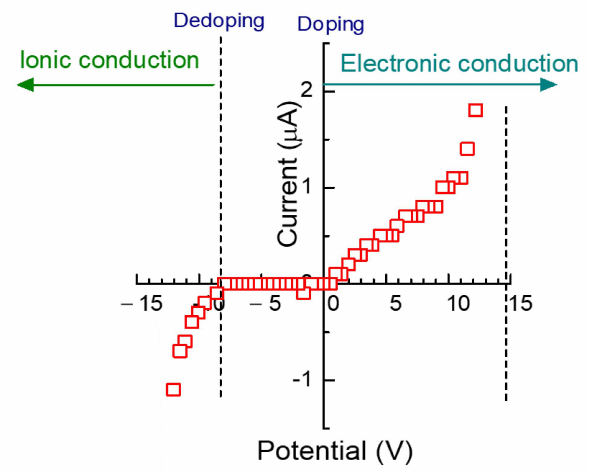
Figure 22. Current change as a function of applied voltage for the sprout/PANI electrochemical